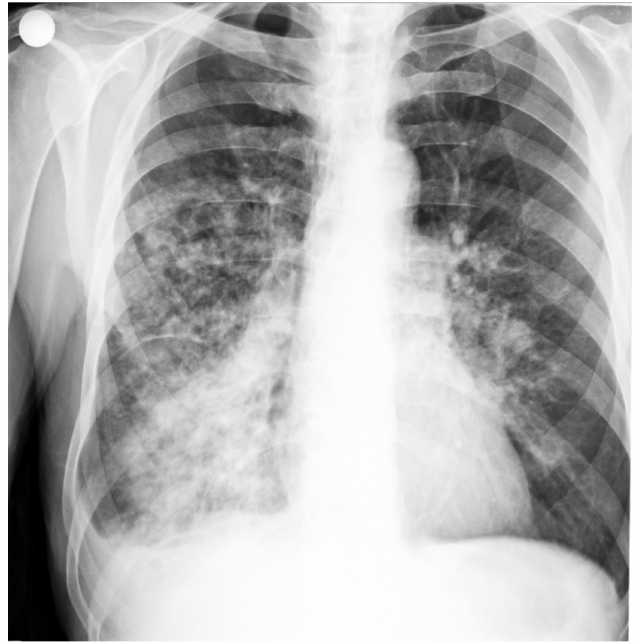
Figure 1. Patient’s Rx cord-lung: interstitial drawing of reticular micronodular type, intensely accentuated perihilar and bilateral infrahilar, with a tendency to bilateral hilum-basal condensation.